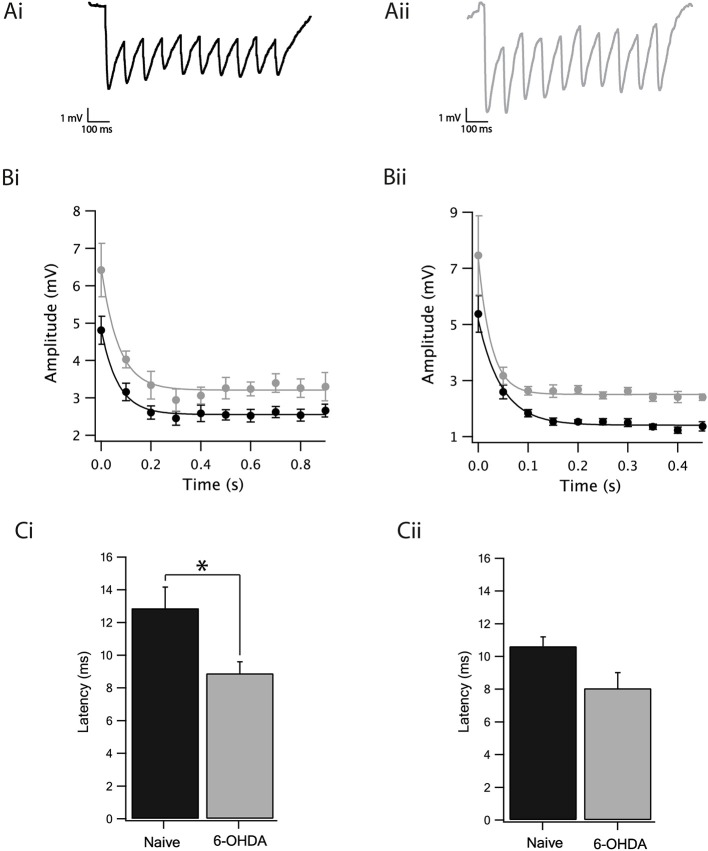
Dopamine depletion increased GABAergic transmission from the GP to the SNr. (A) Example of IPSPs recorded after a 10 Hz stimulation train of SNr neurons from naïve (Ai) and dopamine depleted rats (Aii). (B) Amplitude of the IPSP of naïve (black) dopamine depleted rats (gray) stimulated at 10 Hz (Bi) and at 20 Hz (Bii). Lines are exponential curve fits to the data. (C) Latency of the IPSP of naïve (black) and dopamine depleted (gray) rats stimulated at 10 Hz (Ci) and at 20 Hz (Cii). Values are expressed as the mean ± SEM. *p < 0.05, Mann–Whitney U-test.